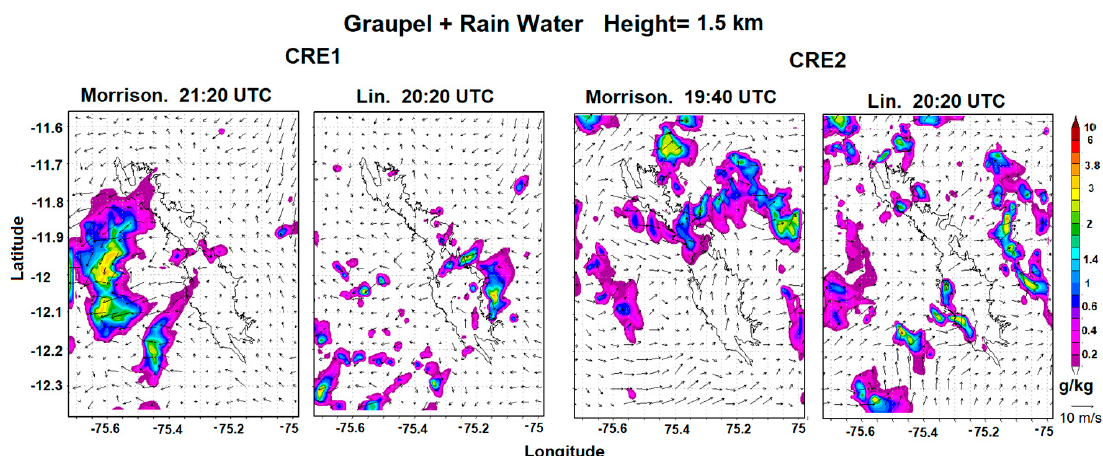
Figure 15. Horizontal cross sections at the 1.5 km a.g.l. WRF level, showing the onset of graupel + rainfall in the neighborhood of HYO in the CRE1 and CRE2 WRF simulations using the Morrison and the Lin schemes. The color bar is in g/kg and the length arrow below indicates 10 m/s in the wind field of the figure.